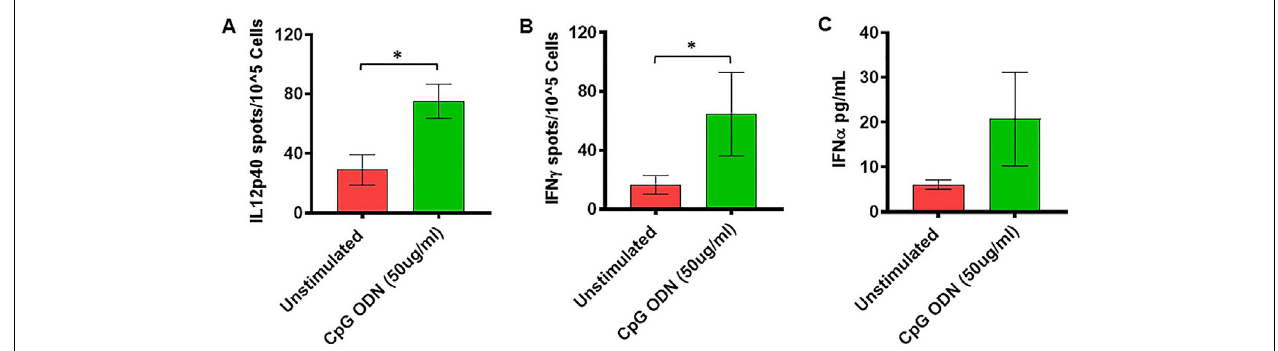
FIGURE 5 | (A,B) IL2p40 and IFN γ cytokine ELISPOT assay. Freshly isolated PBMCs were either unstimulated (medium) or stimulated with CpG ODN (50 µ g/ml) for 36 h at 37 ◦ C. The response to CpG ODN was evaluated by counting the total numbers of IL12p40 (A) and IFN γ (B) SFC adjusted to control medium as a background. (C) IFN α cytokine Luminex magnetic bead assay. In duplicate wells of the 96-well filter plate, PBMC cultures were stimulated with 50 µ g/ml Class C CpG ODN for 36 h at 37 ◦ C. After incubation, 25 µ l of cell-free supernatant was used for measurement of IFN α using Luminex technology (Bio-Plex 200 System) as described in material and methods. The minimum detectable concentration in pg/ml for IFN α (2.9) was used for considering positive responses. Symbols representing significance are: ∗ p <